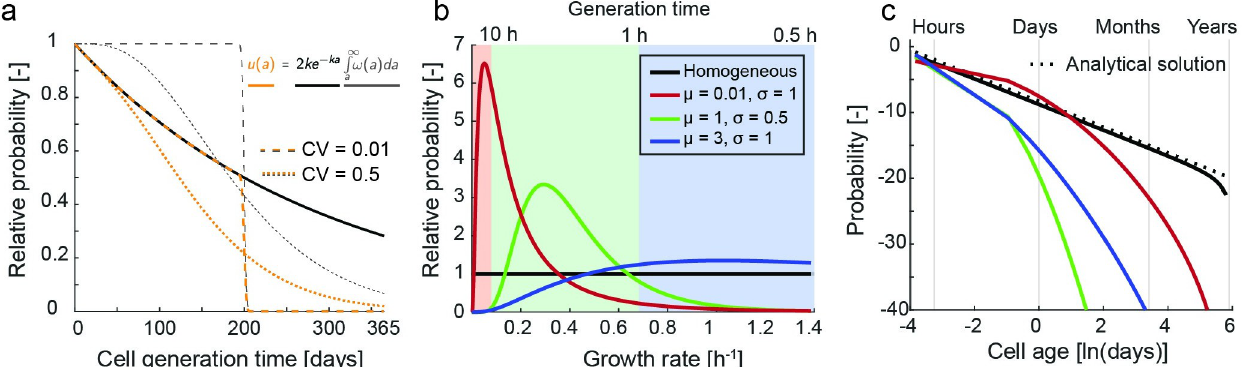
Fig 5. Numerical integration of the heuristic model to obtain bacterial community cell age distributions. a) Visualization of the components in Eq (2) for different CV with showing the exponential component (solid black line), the Gamma survival function (dashed gray lines) and resulting cell age distribution for a single population with a mean generation time of 200 days growing in homogeneous conditions (dashed yellow lines). b) Distribution of weights used for the numerical integration of Eq (2) taken from a lognormal distribution to represent different growth regimes including slow growth (red line), intermediate growth (green line) and rapid growth (blue line). The solid black line represents the homogeneous distribution of growth rates. c) Resulting community cell age distribution when numerically integrating Eq (2) using a CV of 0.1 and the weight distribution in panel b. The dashed line represents the power law of Eq (4) assuming a CV of 0 and homogeneous growth rate distribution whereas the solid black line shows the numerical integration when considering a CV of 0.1 and homogeneous growth rate weights.